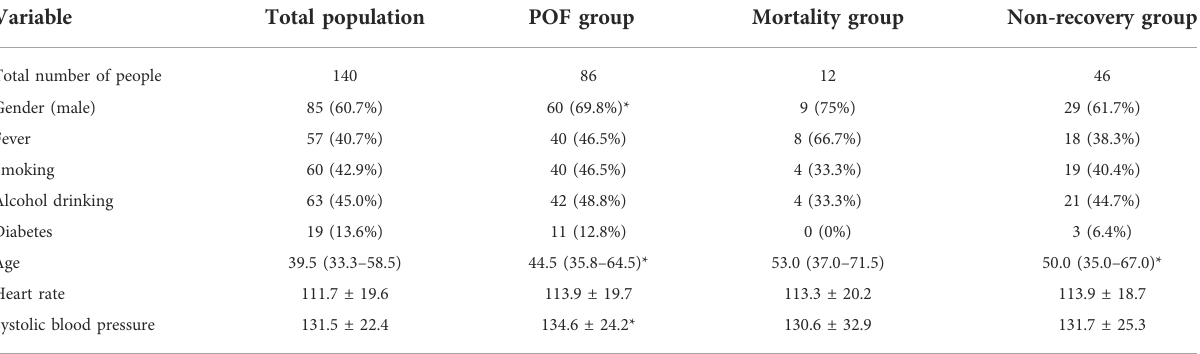
TABLE 1 Demographic information of AP patients.